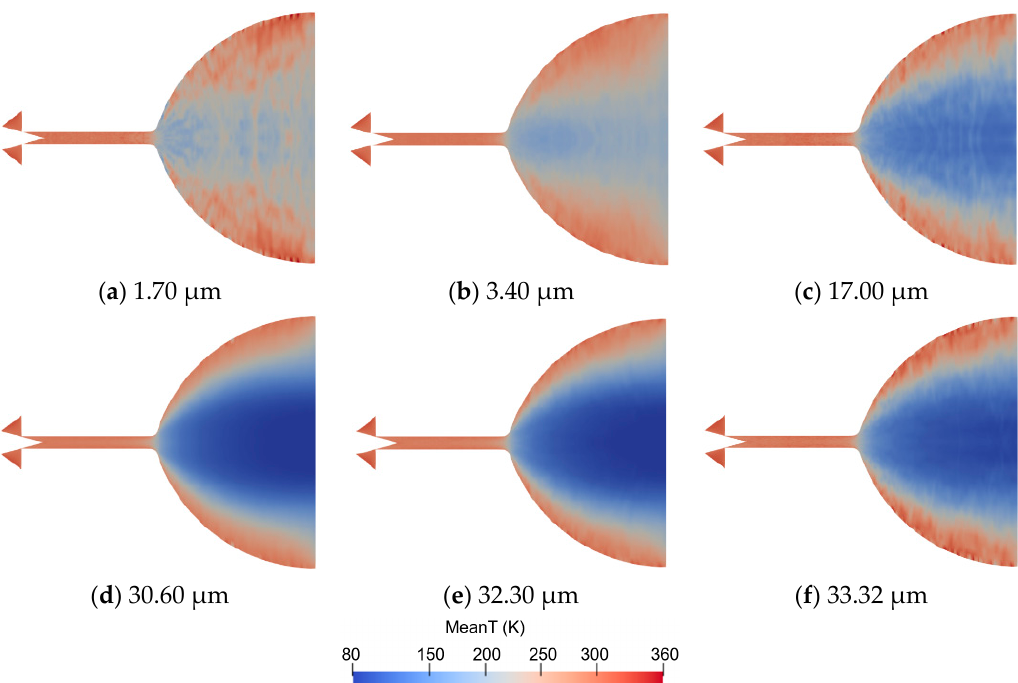
Figure 10. Time ‐ averaged fluid temperature fields in the axial plane with different needle displace ‐ ments at t = 0.1 ms .